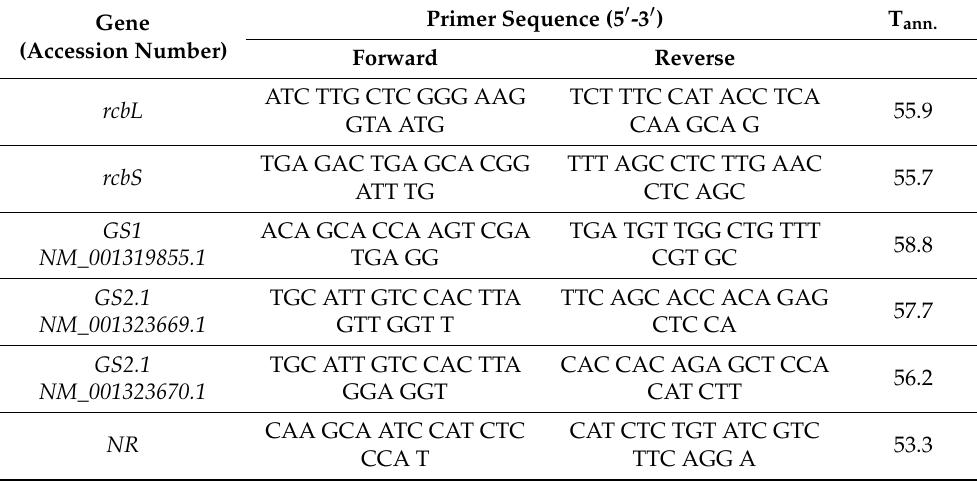
Table 2. Primer sequences (Forward and Reverse) and annealing temperature (Tann) of target genes used for RT-qPCR